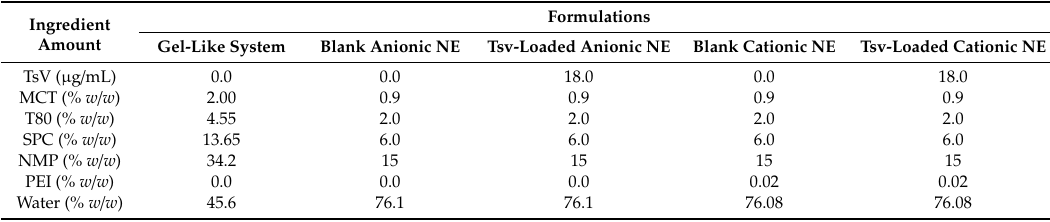
Table 1. Composition of the